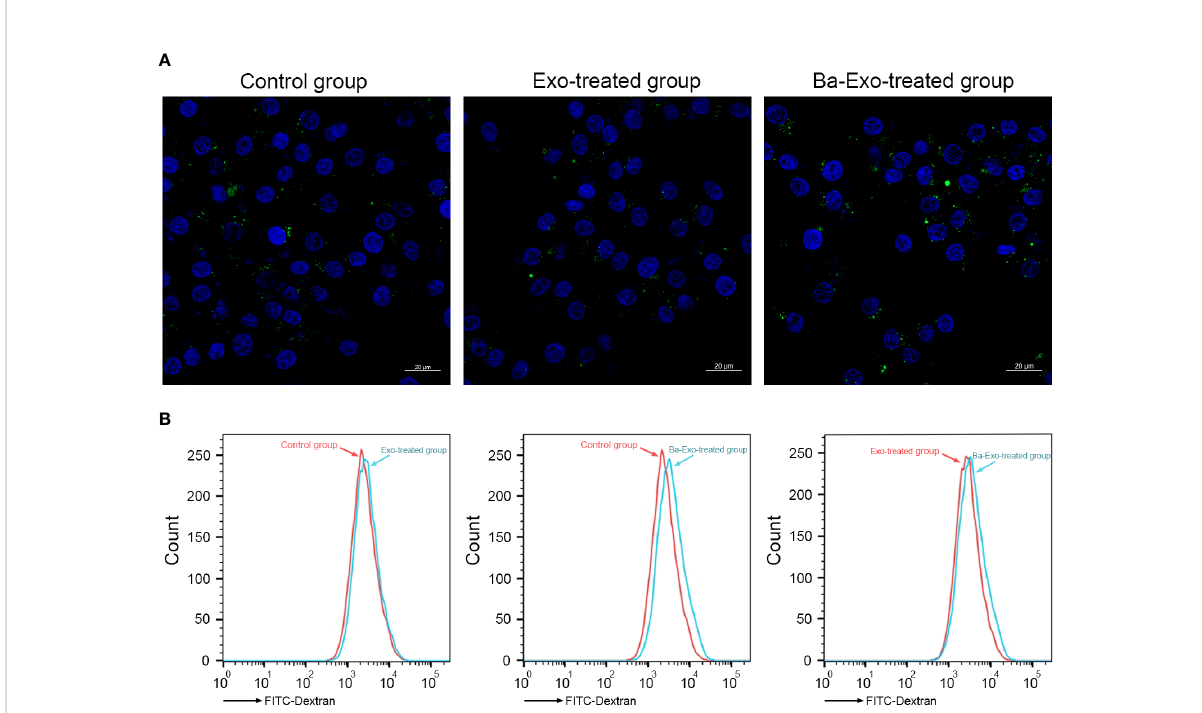
FIGURE 4 Ba-Exo promotes M j phagocytosis. The phagocytosis of 3D4/21 cells were measured by the quantitative uptake of fl uorescein isothiocyanate dextran (FITC-dextran) after Ba-Exo and Exo pretreatment. (A) , The quantitative uptake of FITC-dextran was detected by laser-scanning microscope. Representative images were captured under a laser scanning confocal microscope (Zeiss LSM900). (B) , The quantitative uptake of FITC-dextran was detected by BD FACSCanto ™ fl ow